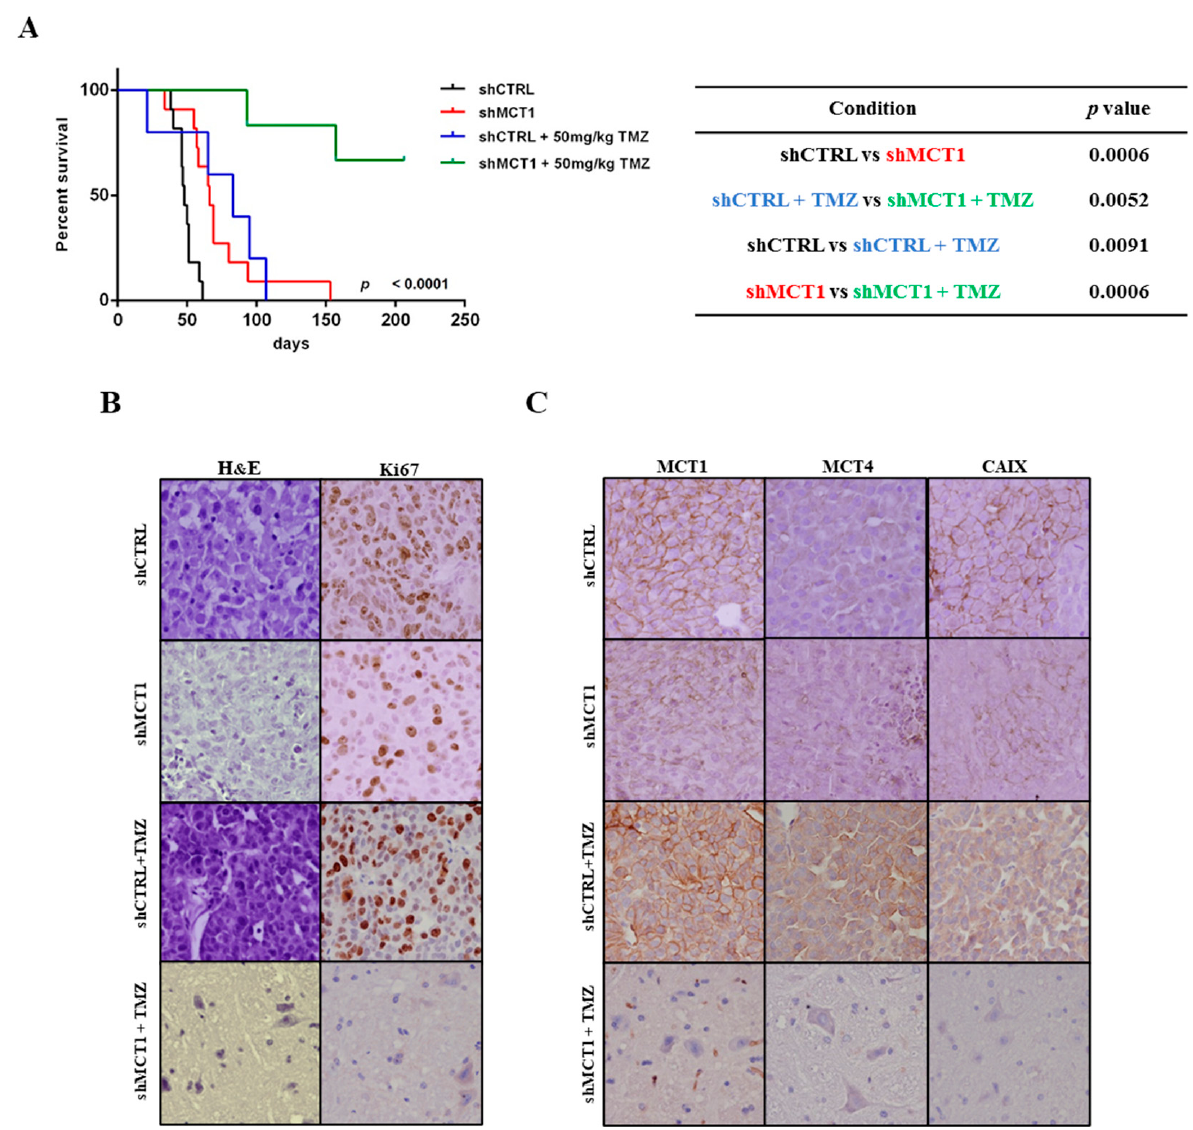
Figure 5. In vivo effect of MCT1 knockdown in GBMs overall survival. ( A ) Kaplan-Meier survival curves for in vivo orthotopic intracranial GBM model. Log-rank test shMCT1 vs. shCTRL vs. shMCT1+ TMZ vs. shCTRL+ TMZ, p < 0.0001 n = 11; n = 11; n = 5; n = 5 per group, respectively; ( B ) Hematoxylin-eosin staining of NSG mice brains; Representative pictures of immunohistochemistry for Ki67 in brain tissues of NSG mice at 400 × magnification. ( C ) MCT1, MCT4 and CAIX expression in shCTRL and shMCT1 plus TMZ in brain tissues at 400 × magnification.